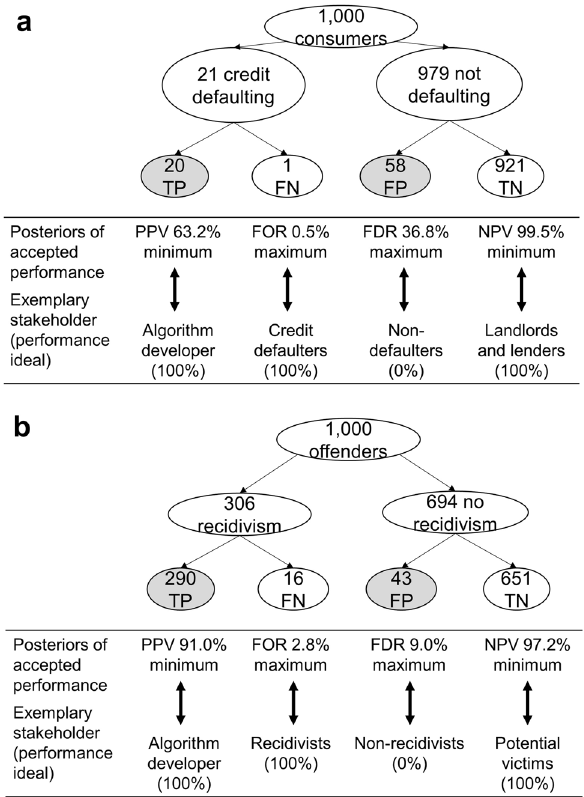
Figure 3. (a,b) Natural frequency trees 45 of algorithm error acceptance for base rates of 2.1% credit defaulters ( a ) and of 30.6% recidivists ( b ), and comparison of minimum performance acceptance (posterior probabilities) of respondents with performance ideals of exemplary stakeholders. Posteriors shown are the acceptable minimum PPV (positive predictive value; e.g. that a person will commit another crime if testing positive), minimum NPV (negative predictive value: e.g. that a person will not commit another crime if testing negative), maximum FOR (false omission rate = 1-NPV), and maximum FDR (1—PPV); TP (true positive), TN (true negative), FP (false positive), FN (false negative). Note that averages of posteriors that were calculated on the individual level are not equal to posteriors based on aggregated TPs, FPs, TNs, and